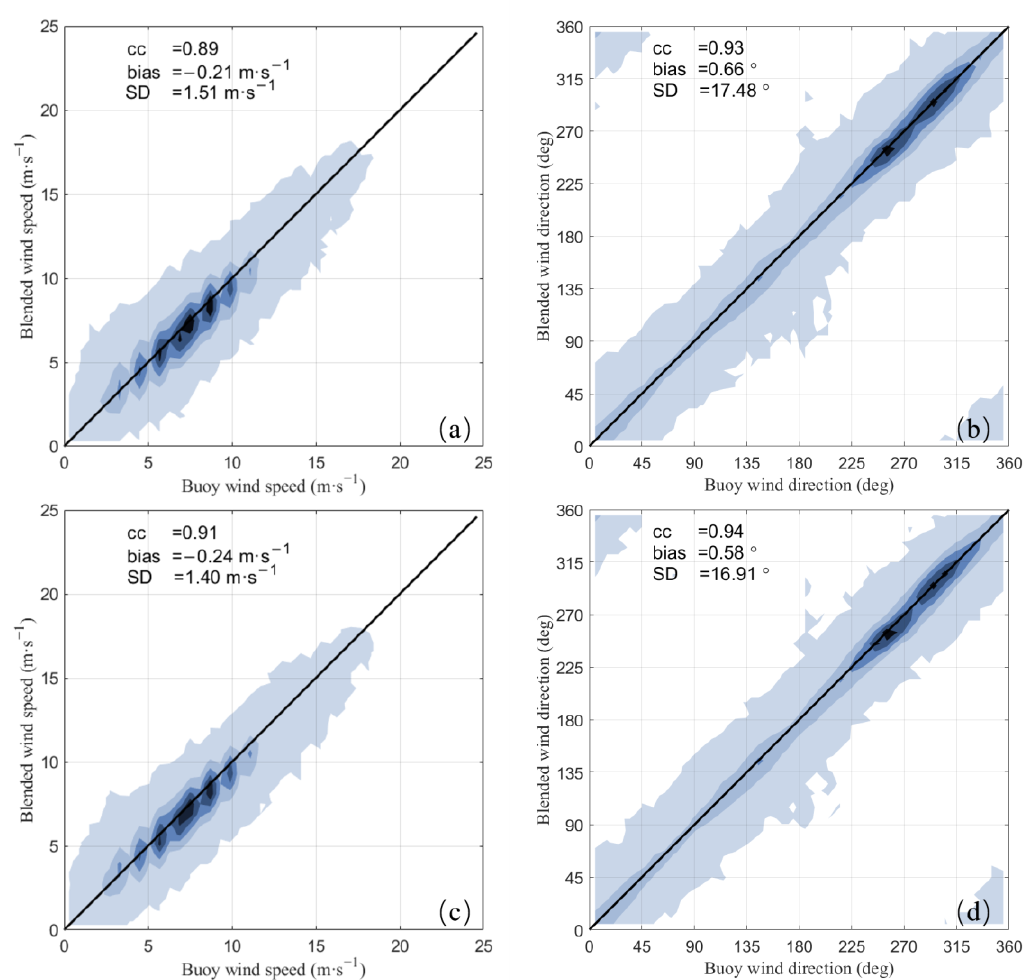
Figure 6. Blended winds versus buoy measurements: GSF-derived wind speed ( a ) and direction ( b ); EBEC-derived wind speed ( c ) and direction ( d ).